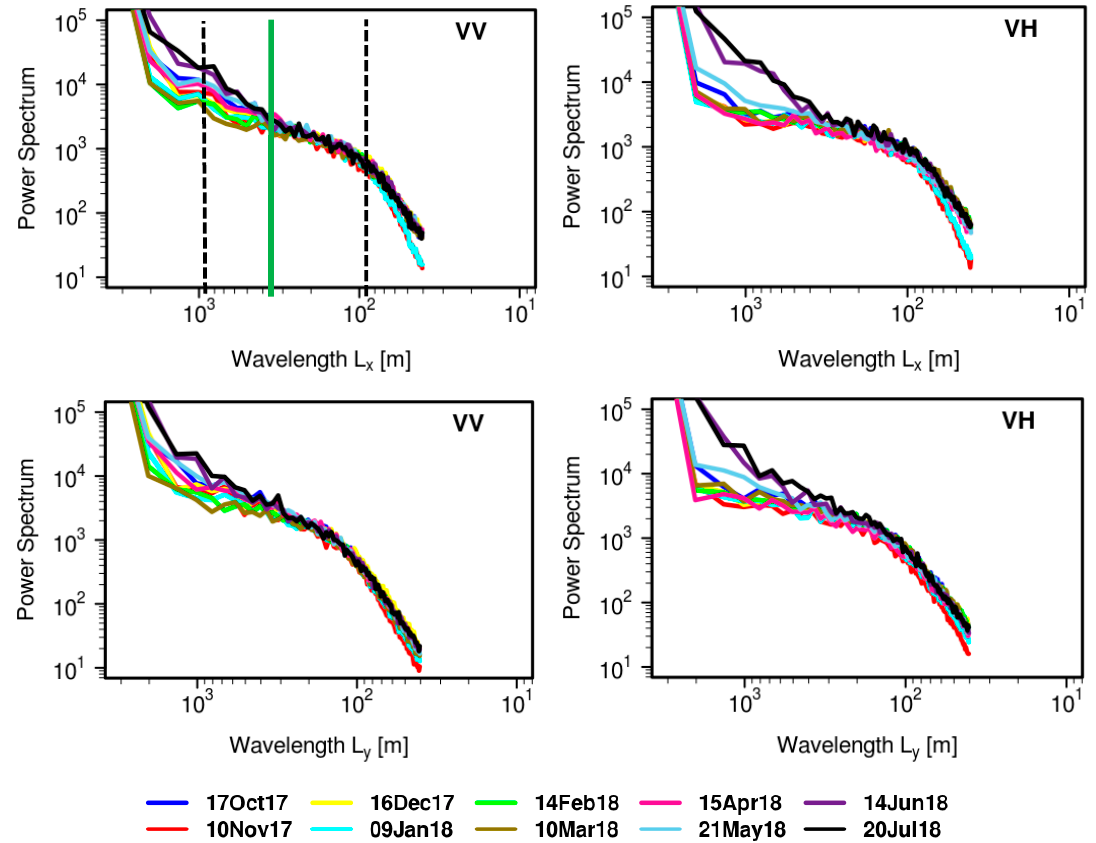
Figure 18. BSC power spectra for North Dakota in the x- (top row) and y- (bottom row) directions. The black vertical lines in the top-left panel mark the range of scales used to calculate the slope (Table S4); the green vertical line marks the scaling